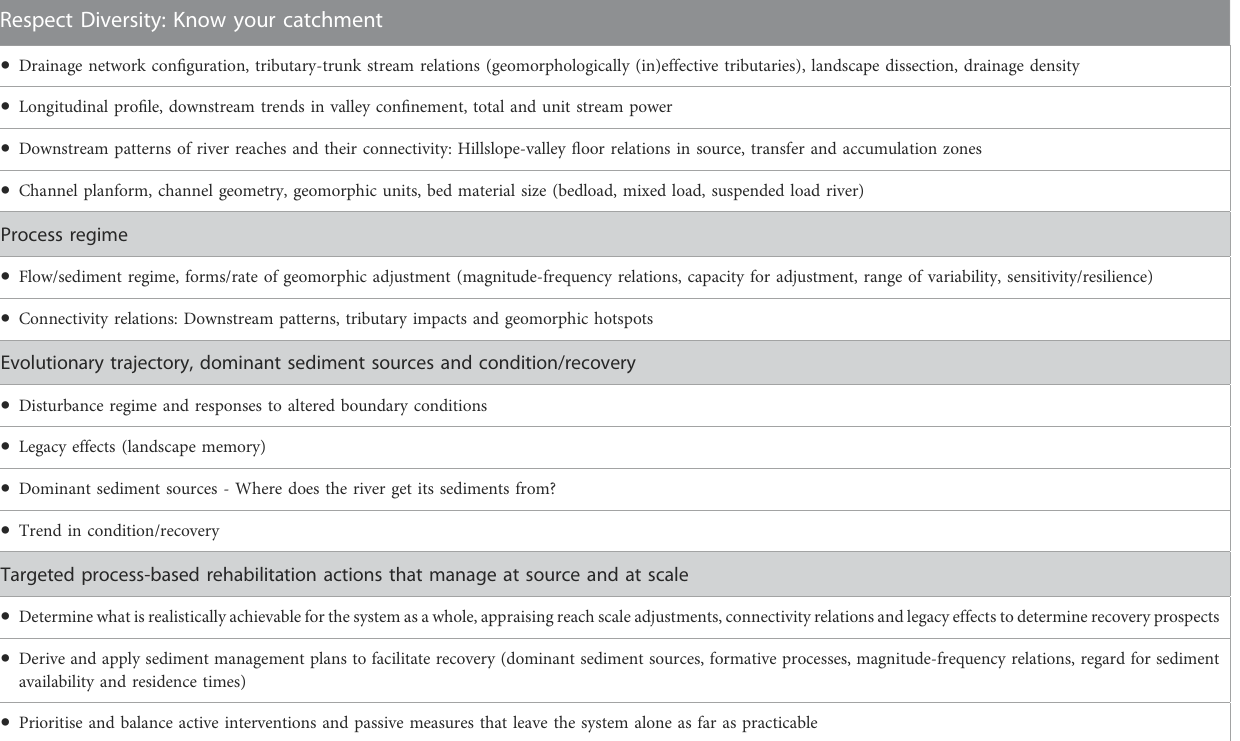
TABLE 1 Key attributes of geomorphic river stories to support rehabilitation programmes that apply nature-based solutions that work with the river (based on Truths of the Riverscape proposed by Brierley and Fryirs (2022)). Respect Diversity: Know your